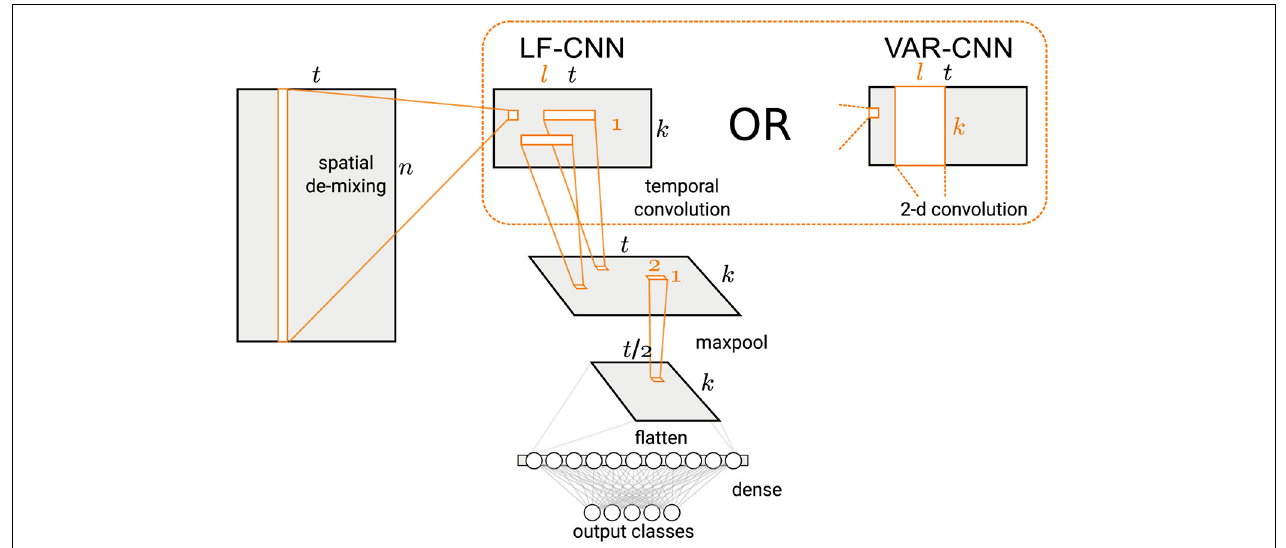
FIGURE 2 | Architecture of the CNNs used in this study (Figure 1 in Zubarev et al., 2019, license CC BY-NC-ND 4.0).